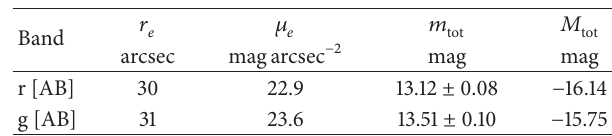
Table 1: Measured optical photometric